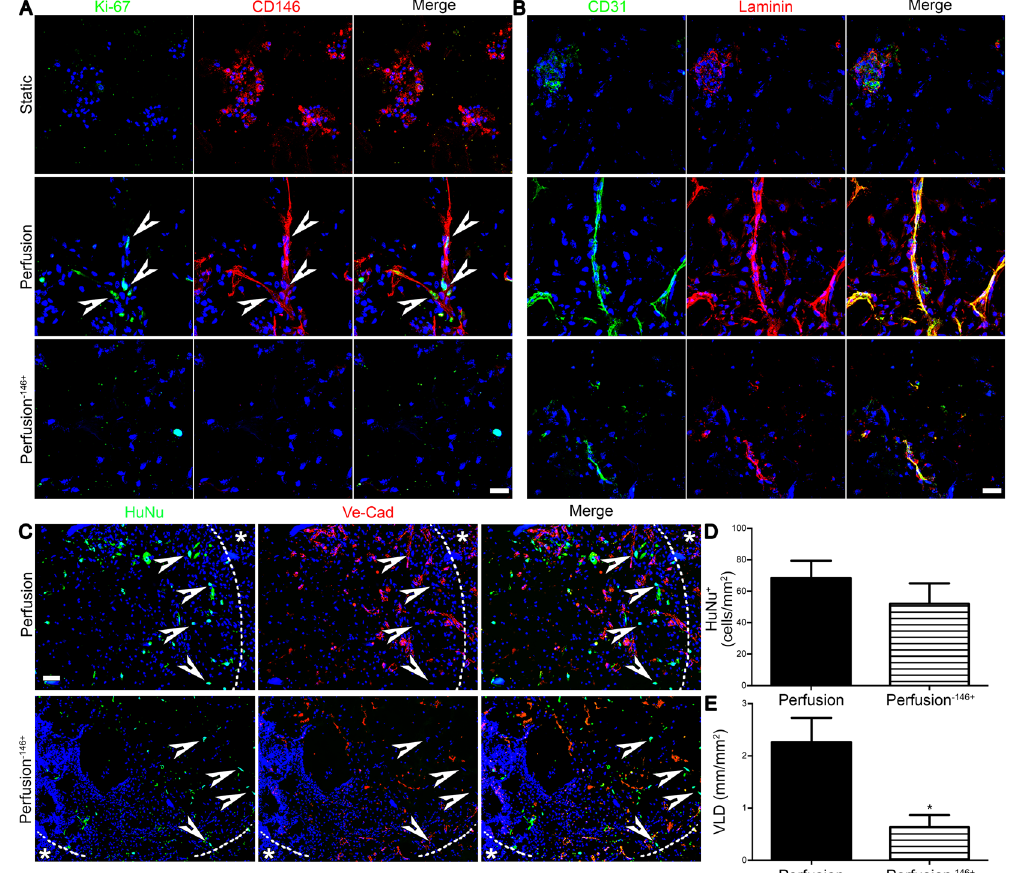
Figure 7. Pericyte depletion decreased cell proliferation and in vitro pre- and in vivo early vascularization. Patches were analysed after 3 days in vivo . ( A ) Representative in vitro immunofluorescence images of proliferating cells (Ki-67; green) and pericytes (CD146; red). White arrows indicate proliferating CD146 + cells. Scale bar = 20 μ m. ( B ) Representative in vitro immunofluorescence images for EC (CD31; green) and basal lamina (laminin; red). Scale bar = 20 μ m. ( C ) Representative in vivo immunofluorescence for human cells (HuNu; green) and EC (Ve-Cad; red). Nuclei were stained with DAPI (blue in A – C ). Dashed line outlines the border between the patch and the rat tissue (identified by the * ). White arrows indicate human cells. Scale bar = 50 μ m. ( D ) Quantification for the HuNu + cells normalized over the analysed area. ( E ) VLD quantification normalized over the analysed area. * P < 0.05 (n donor =